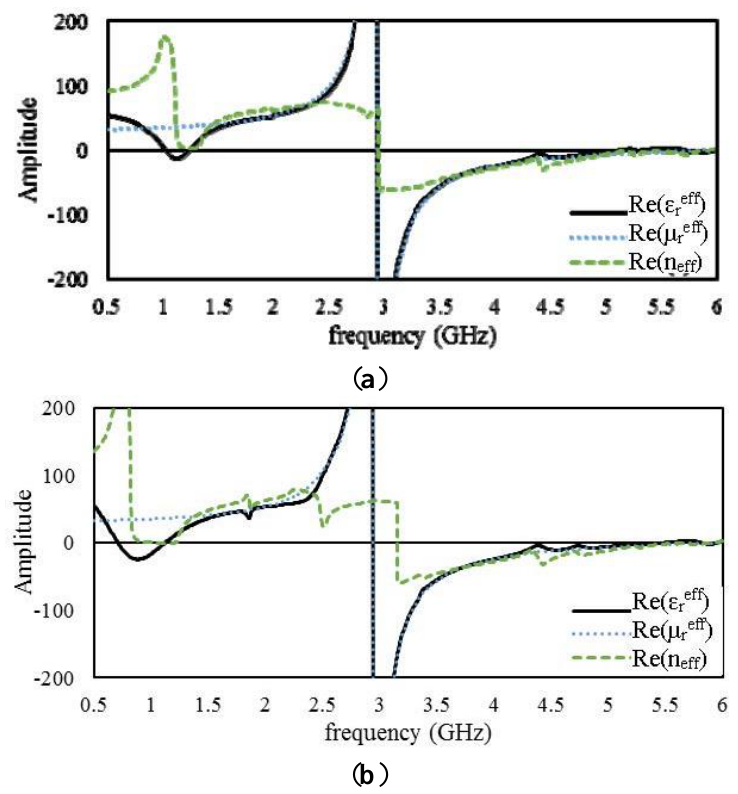
Figure 10. Real parts of the effective parameters of 2 × 2 arrays of unit cell C: ( a ) open array and ( b ) interconnected